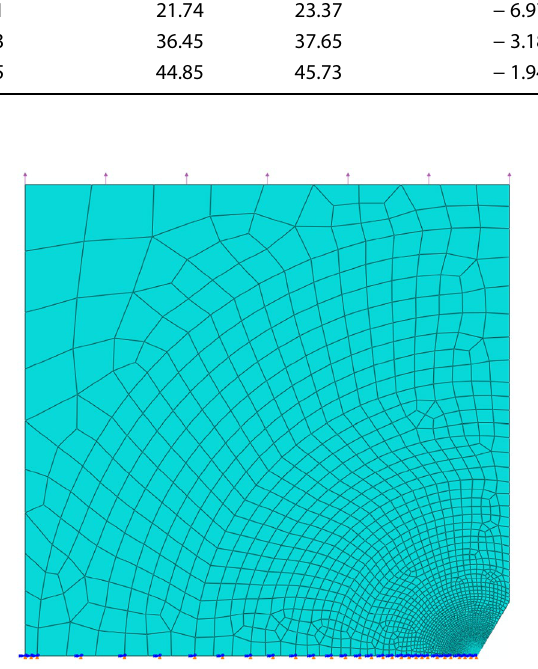
Fig. 11 Half symmetry mesh model for plate with 120-degree v-notch